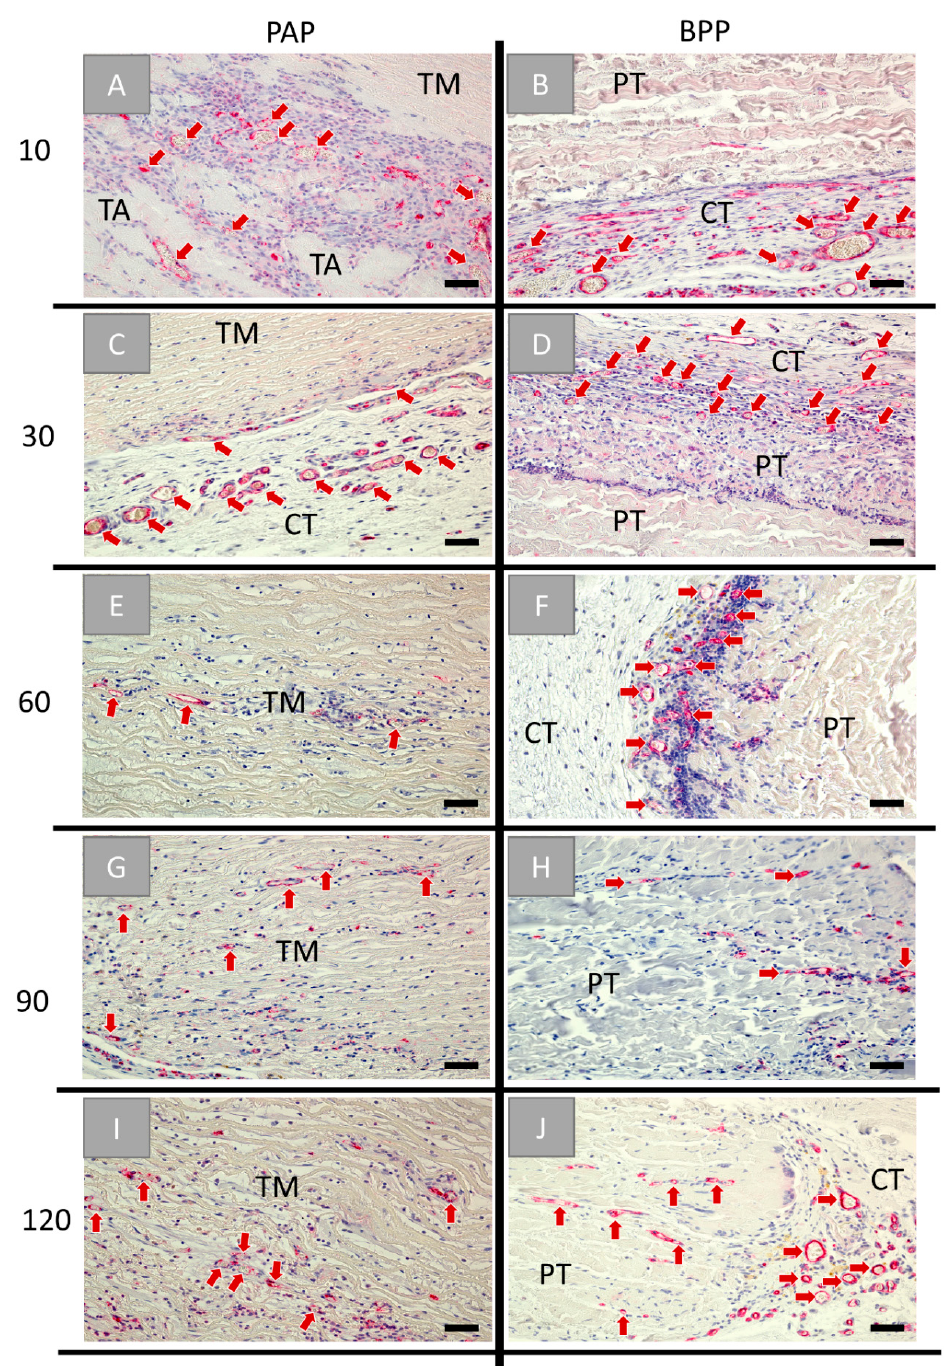
Figure 7. Histological images of the immunohistochemical CD31-detection within the implantation beds of the porcine aorta patch (PAP, left row) and the bovine vessel patch (BPP, right row) at ( A , B ) day 10, ( C , D ) day 30, ( E , F ) day 60, ( G , H ) day 90, and ( I , J ) day 120 post implantationem within the subcutaneous connective tissue (CT). Red arrows: blood vessels, TA: tunica adventitia, TM: tunica media, PT: pericardial tissue (Immunohistochemical CD31-stainings, 20× magnifications, scale bars = 50 µm).